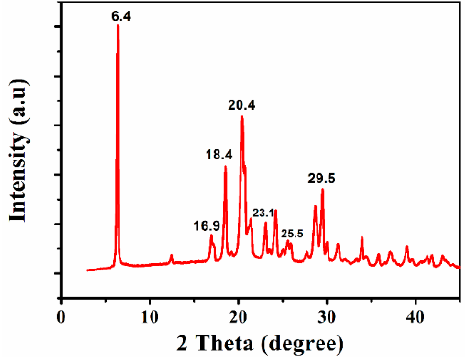
Figure 4. X-ray diffraction (XRD) spectrum of sulfonated PANI oligomers.